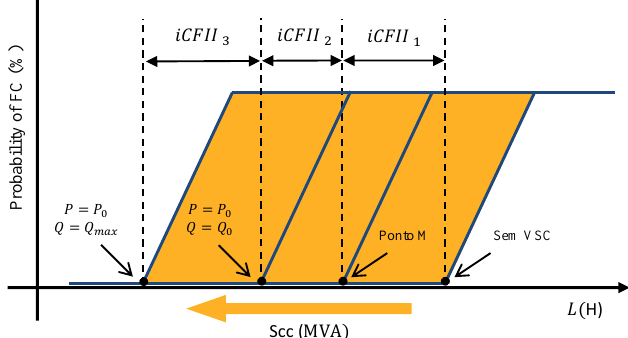
Figure 2. Graphic representation of i CFII